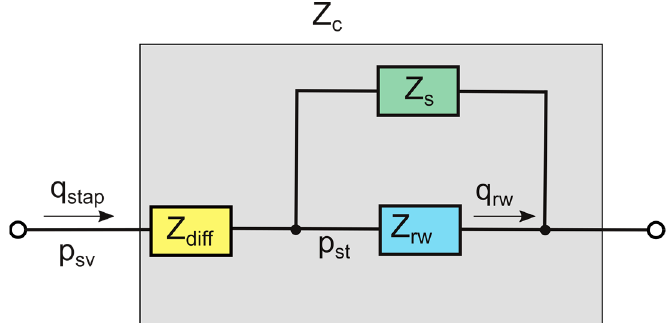
Figure A3. Equivalent electrical circuit representing a lumped element model (LEM) of the cochlea